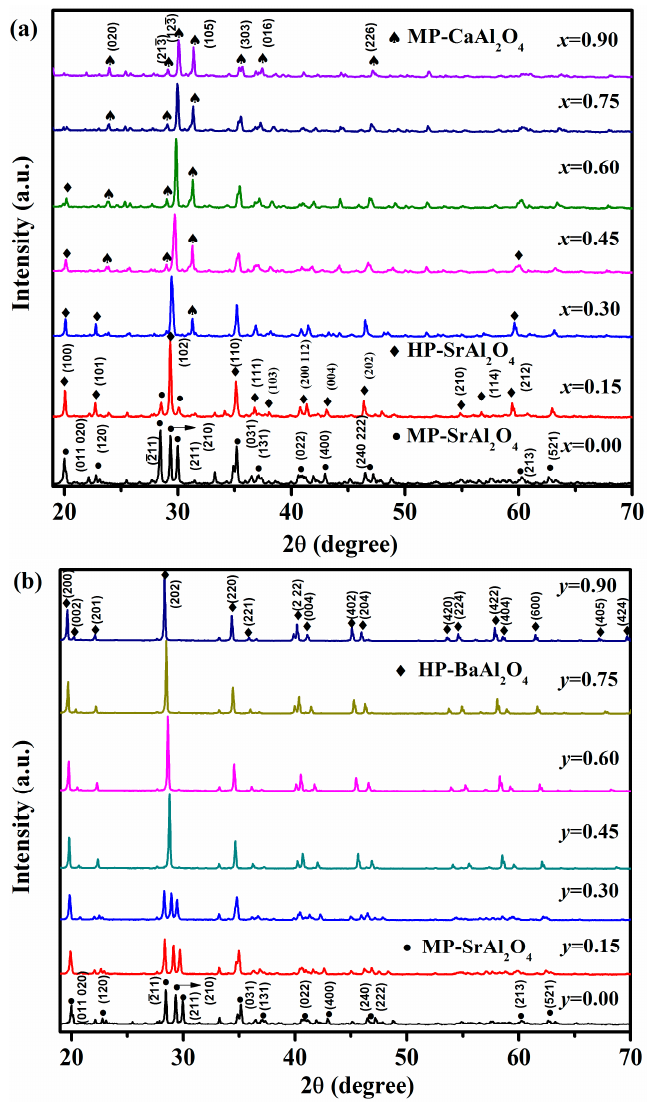
Figure 1. ( a ) X-ray powder diffraction (XRD) patterns of Sr 0.90 − x Ca x Al 2 O 4 :0.05Eu 2+ , 0.05Dy 3+ phosphors with various x ( x = 0.00, 0.15, 0.30, 0.45, 0.60, 0.75, 0.90); ( b ) XRD patterns of Sr 0.90 − y Ba y Al 2 O 4 :0.05Eu 2+ , 0.05Dy 3+ phosphors with various y ( y = 0.00, 0.15, 0.30, 0.45, 0.60, 0.75, 0.90).